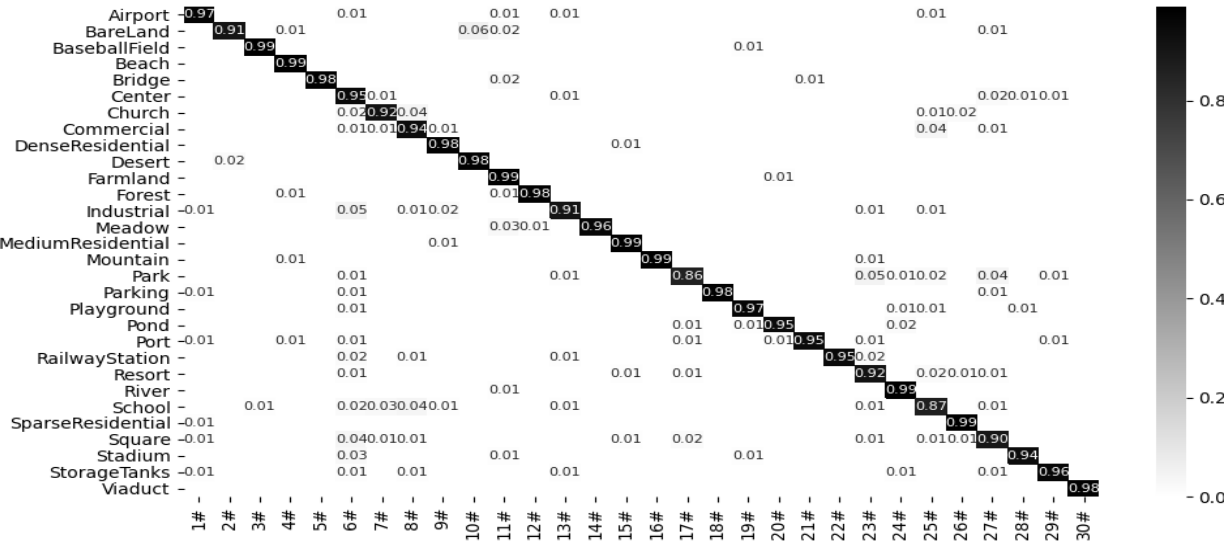
Figure 13. Confusion matrix of the proposed method on the AID30 dataset (50/50).